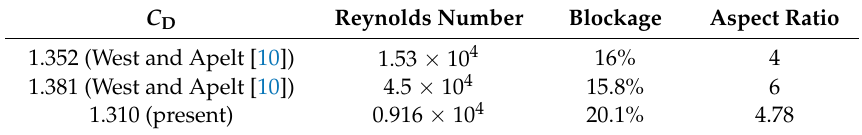
Table 1. Comparisons of the drag coefficient between present result and West and Apelt